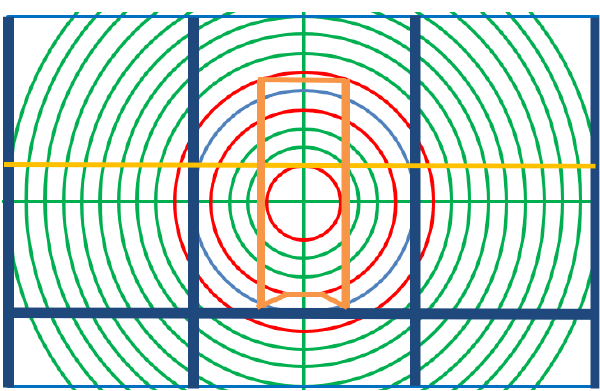
Figure 14. Placement of “structures” begins with center panel. Source: the author.